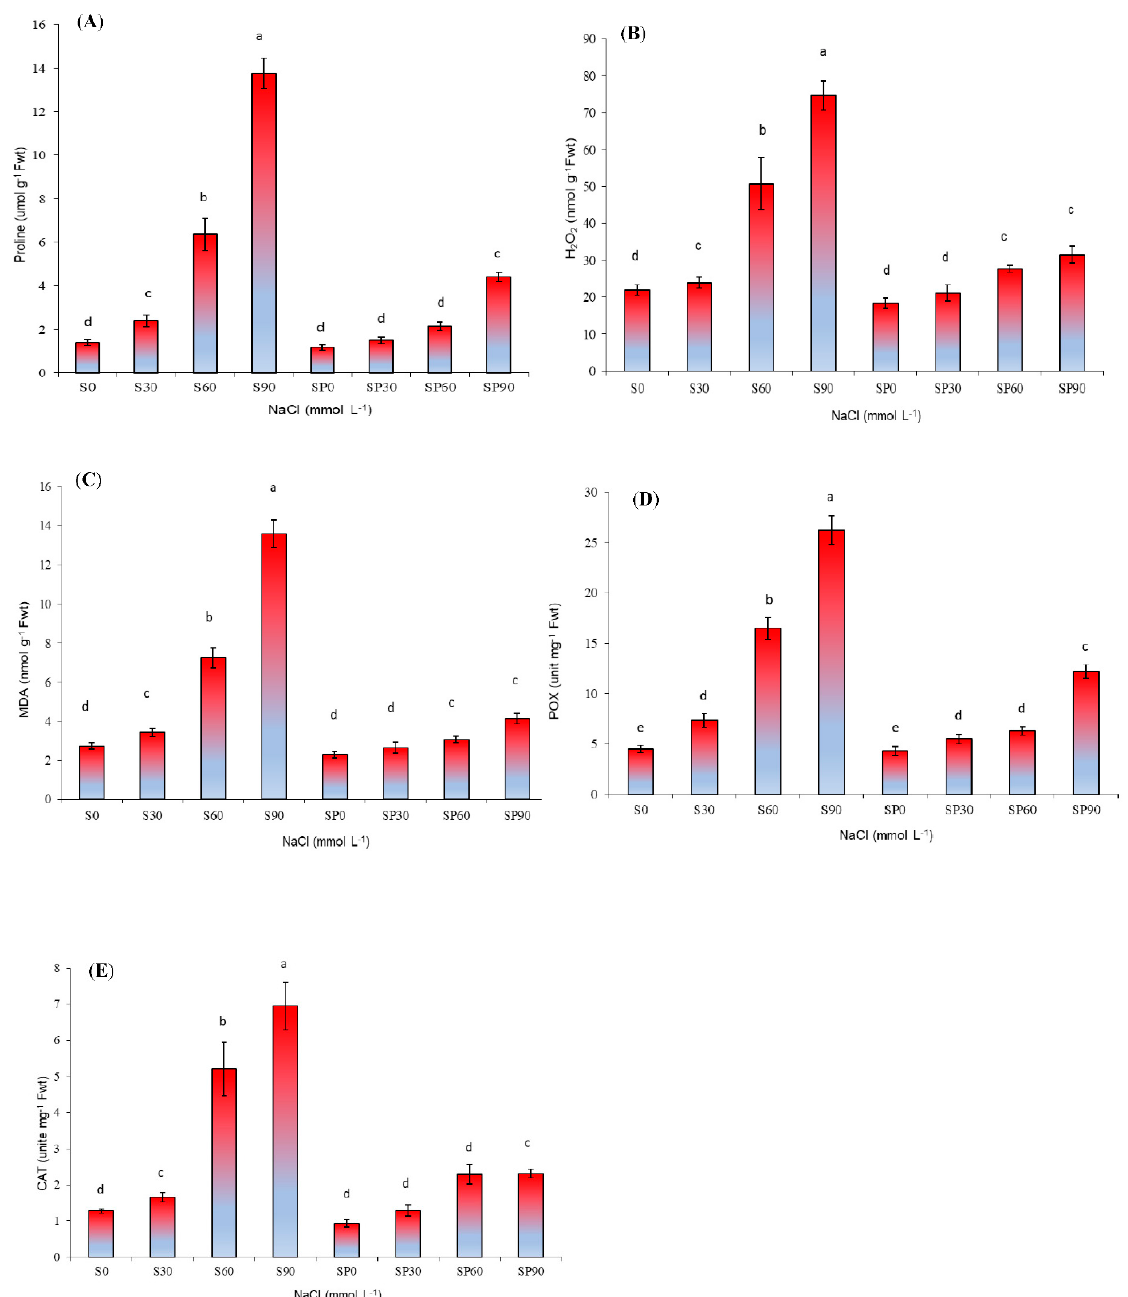
Figure 3. Proline ( A ), H 2 O 2 ( B ), and malondialdehyde (MDA) ( C ) contents; peroxidase enzyme activity (POX) ( D ) and catalase enzyme activity (CAT) ( E ) antioxidant enzyme contents of strawberry plants grown alone or in combination with P. oleracea at differing NaCl levels (0, 30, 60, and 90 mmol L − 1 ). S: a strawberry grown alone; SP: the strawberry and P. oleracea companionship; TSS: total soluble solids.